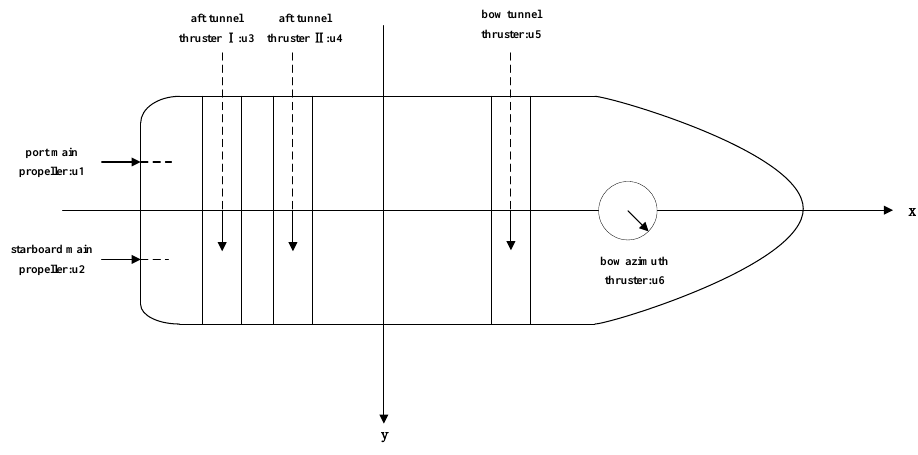
Figure 3. Schematic drawing showing the UMV thruster configuration.